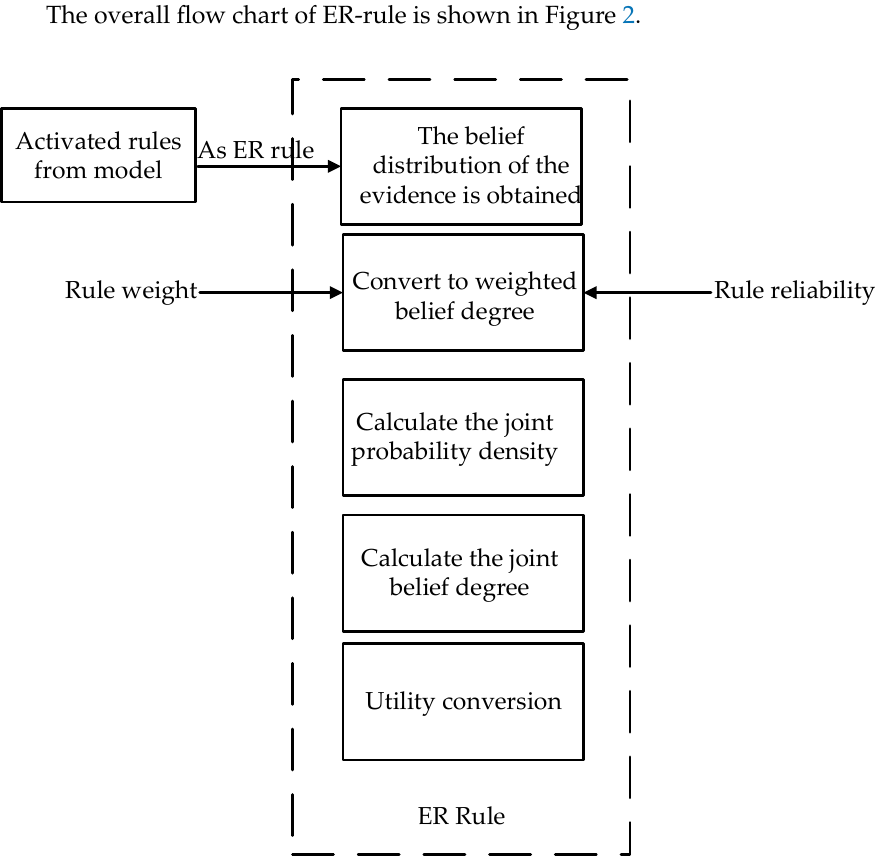
Figure 2. Flow chart of the ER rule.